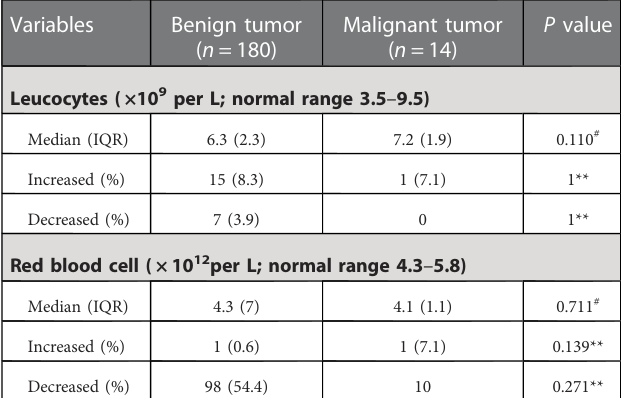
TABLE 3 Echocardiographic and electrocardiogram characteristics of primary atrial tumor